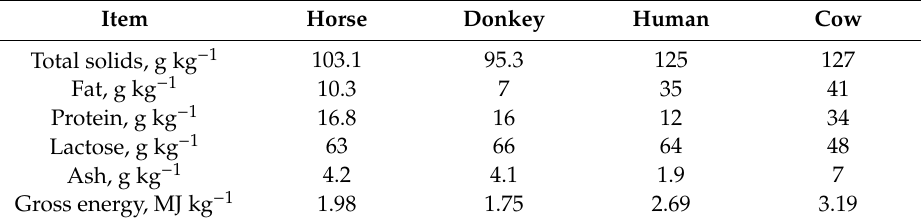
Table 1. Average milk gross composition and energy content from di ff erent species 1 . Item Horse Donkey Human Cow Total solids, g kg − 1 103.1 95.3 125 127 Fat, g kg − 1 10.3 Protein, g kg −